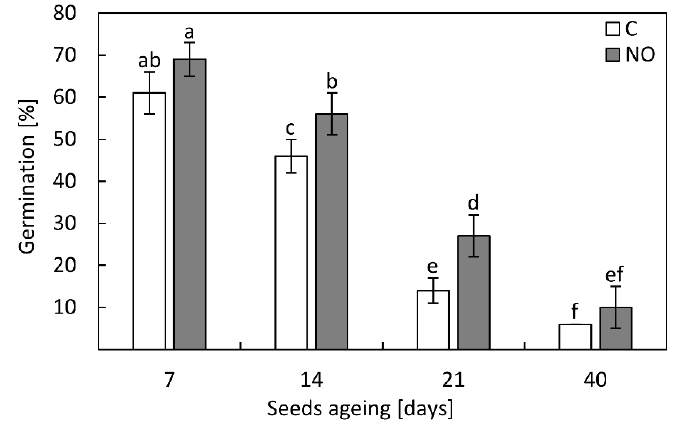
Figure 3. The germination rate of the apple embryos isolated from seeds subjected to accelerated ageing for 7, 14, 21 and 40 days (C) or the embryos isolated from aged seeds and treated with NO (NO). Values are the average of three independent experiments with 90 embryos in each (45 control and 45 NO treated). Different letters indicate significant differences obtained by Tukey’s test ( p < 0.05).